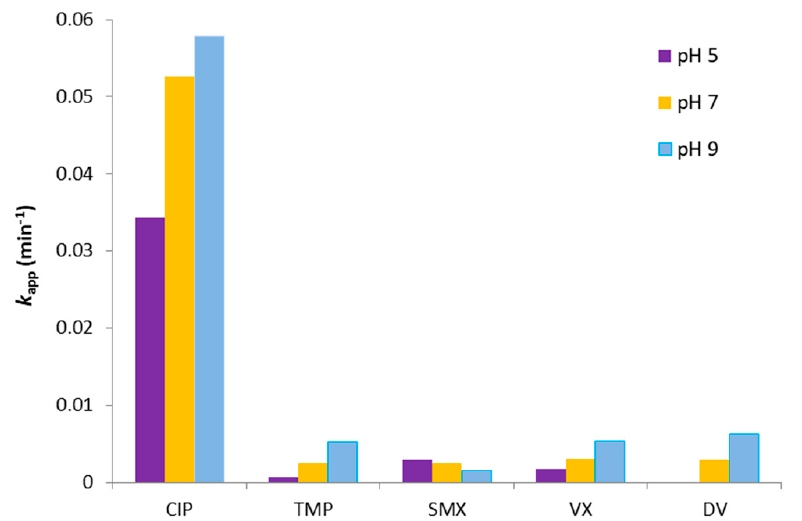
Figure 8. k app at different initial pH for the mixture of the five PhACs in MQ water, C 0 = 2 mg/L each (UV-A photocatalysis).